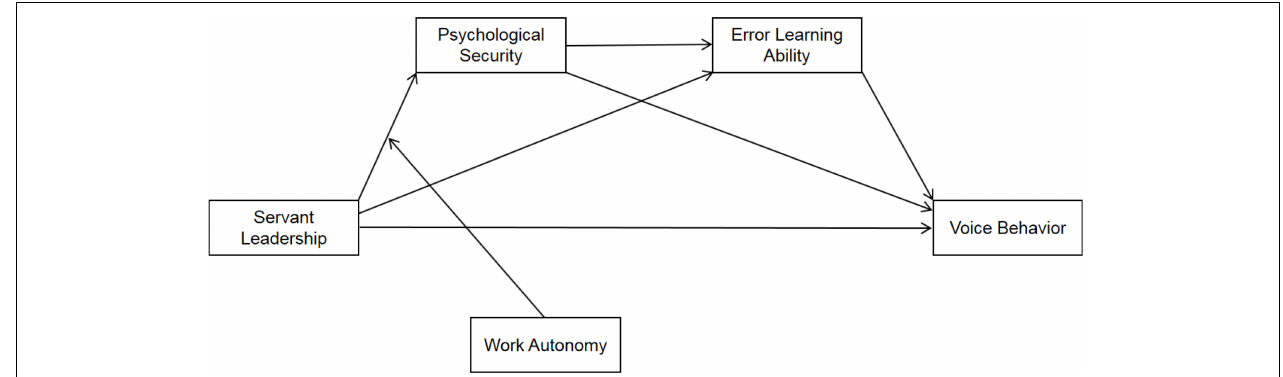
FIGURE 1 | Theoretical hypothesis